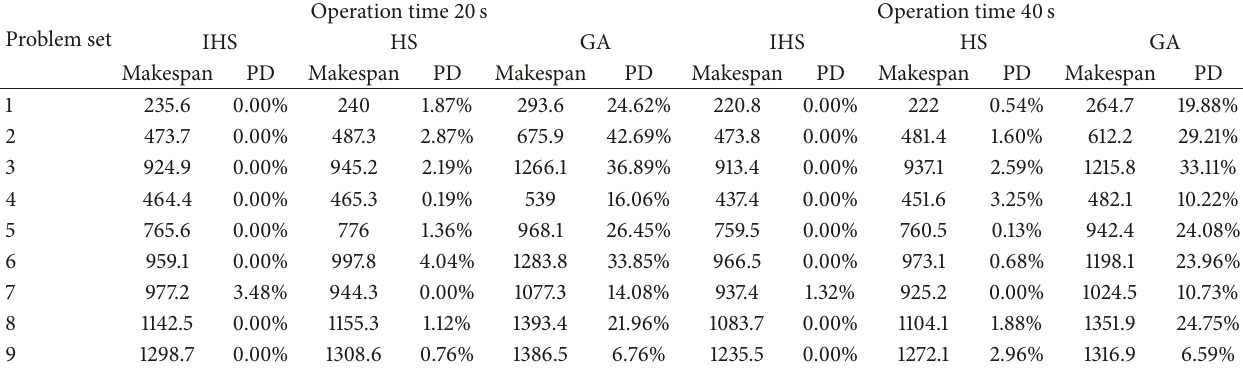
Table 7: Makespan and percentage deviation under the operation times 20 s and 40